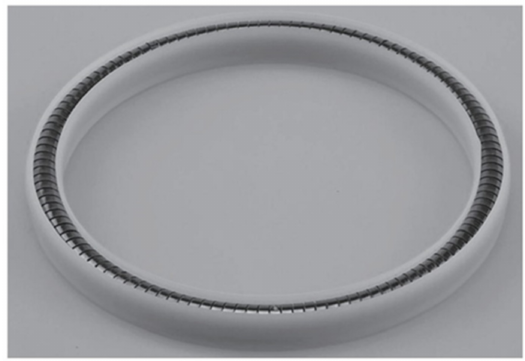
Figure 3. Plug seal